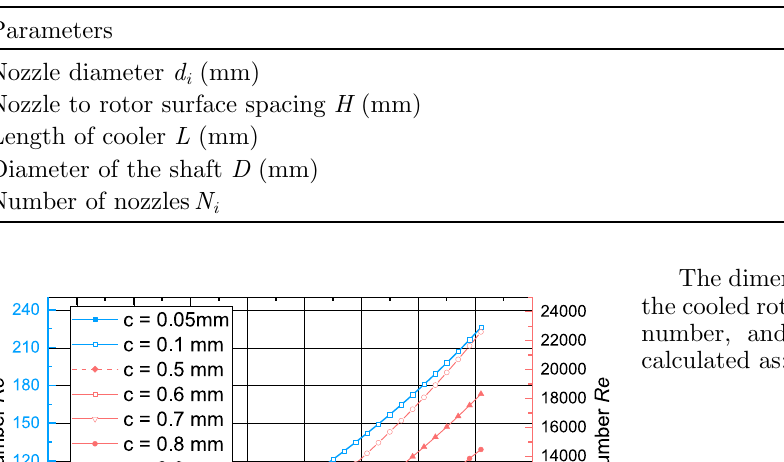
Table 2. Parameter range of cooler for the numerical